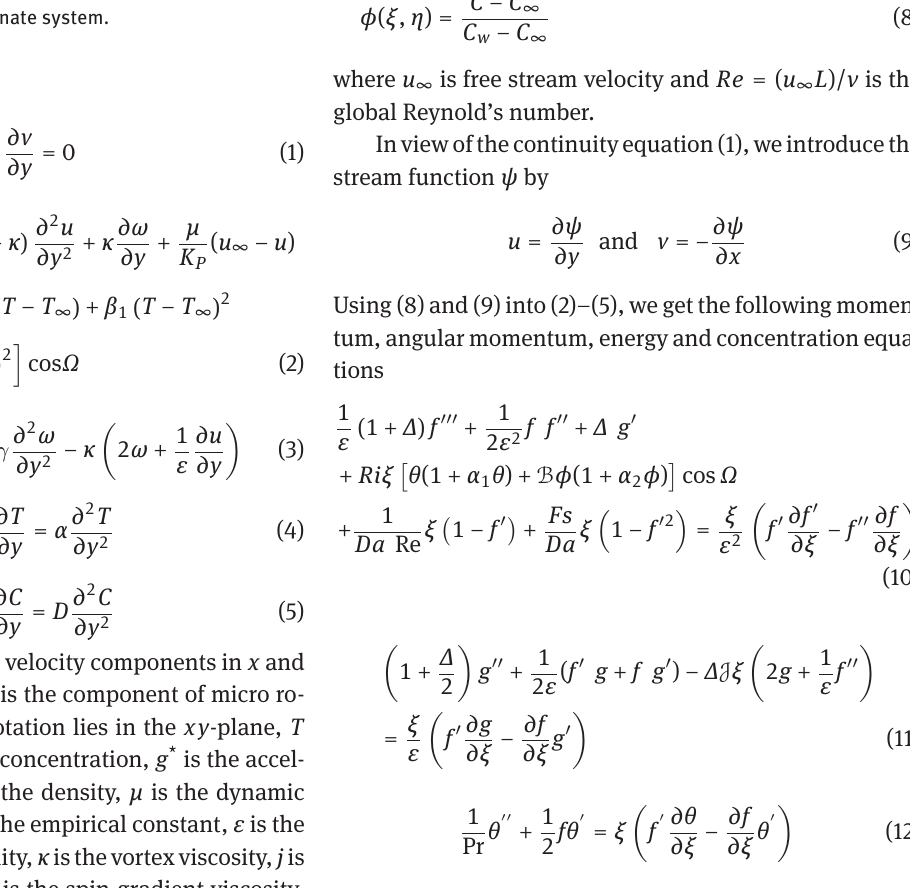
Fig. 1: Physical model and coordinate